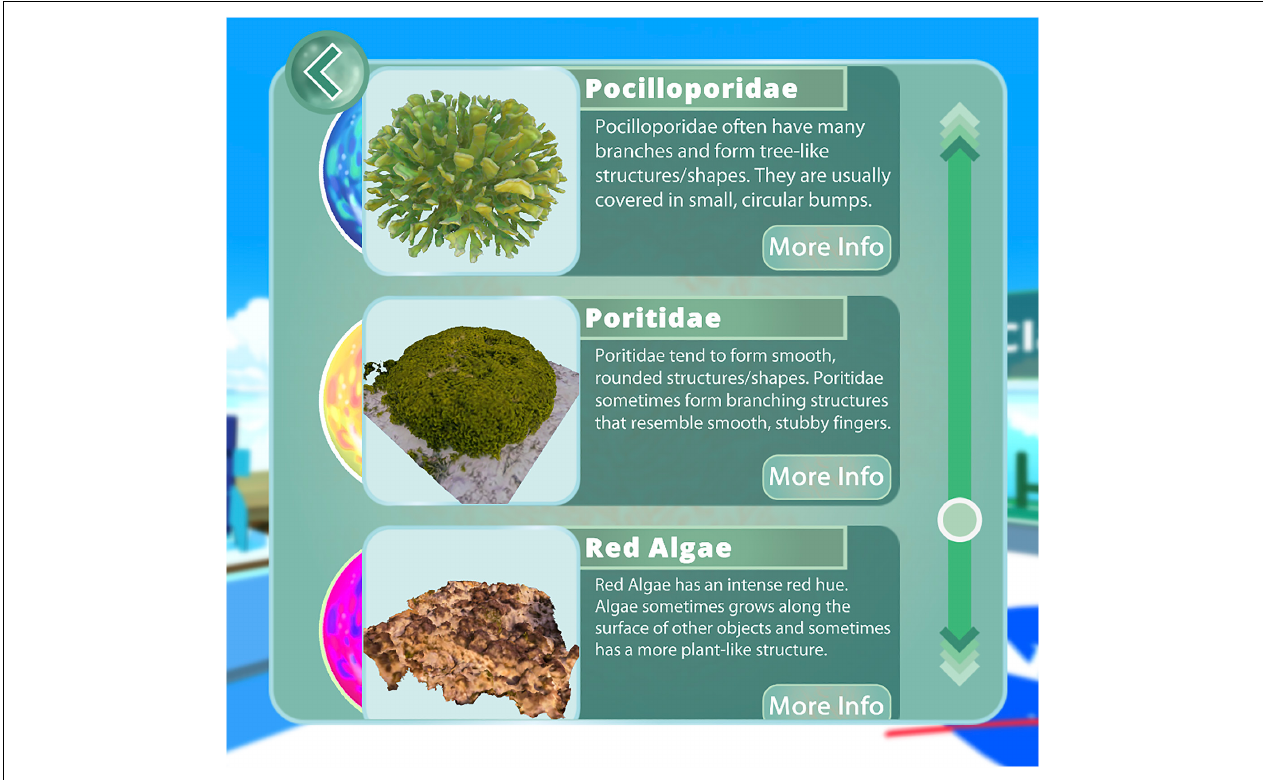
FIGURE 4 | NeMO-Net 3D field guide. At any time, players may access the field guide for instructional content on how to label correctly. Each class label contains real-world 3D images, 2D images, and detailed text describing each of the 26 class labels. Class labels are gradually introduced to players in an interactive format.